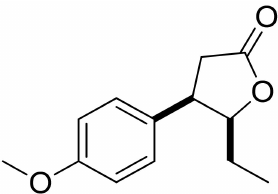
Figure 5. An anisaldehyde lactone derivative. A series of lactones were prepared from natural aromatic aldehydes by the Skro- biszewski group. All γ -butyrolactones were tested for their antifungal activity against four Fusarium strains, and three γ -butyrolactones (Figure 6) presented strong activity. The first derivative (Figure 6a) presented considerably high activity (50%) against F. avenaceum and F. oxysporum . The second lactone (Figure 6b) was the most active; against F. oxysporum , it showed 70% growth inhibition, and against F. avenaceum , F. solani , and F. culmorum , this lactone displayed 66%, 66%, and 55% growth inhibition, respectively. The third com- pound (Figure 6c) also exhibited approximately 50% activity against F. avenaceum , F. solani , and F. culmorum . Moreover, it was proposed that the reason for such results was that the most active compounds possess a benzodioxol ring at the β -position [22].